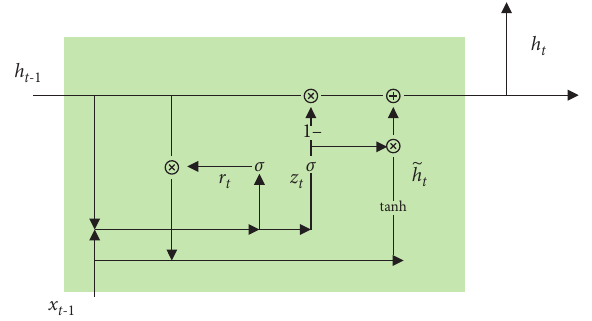
Figure 4: The structure diagram of